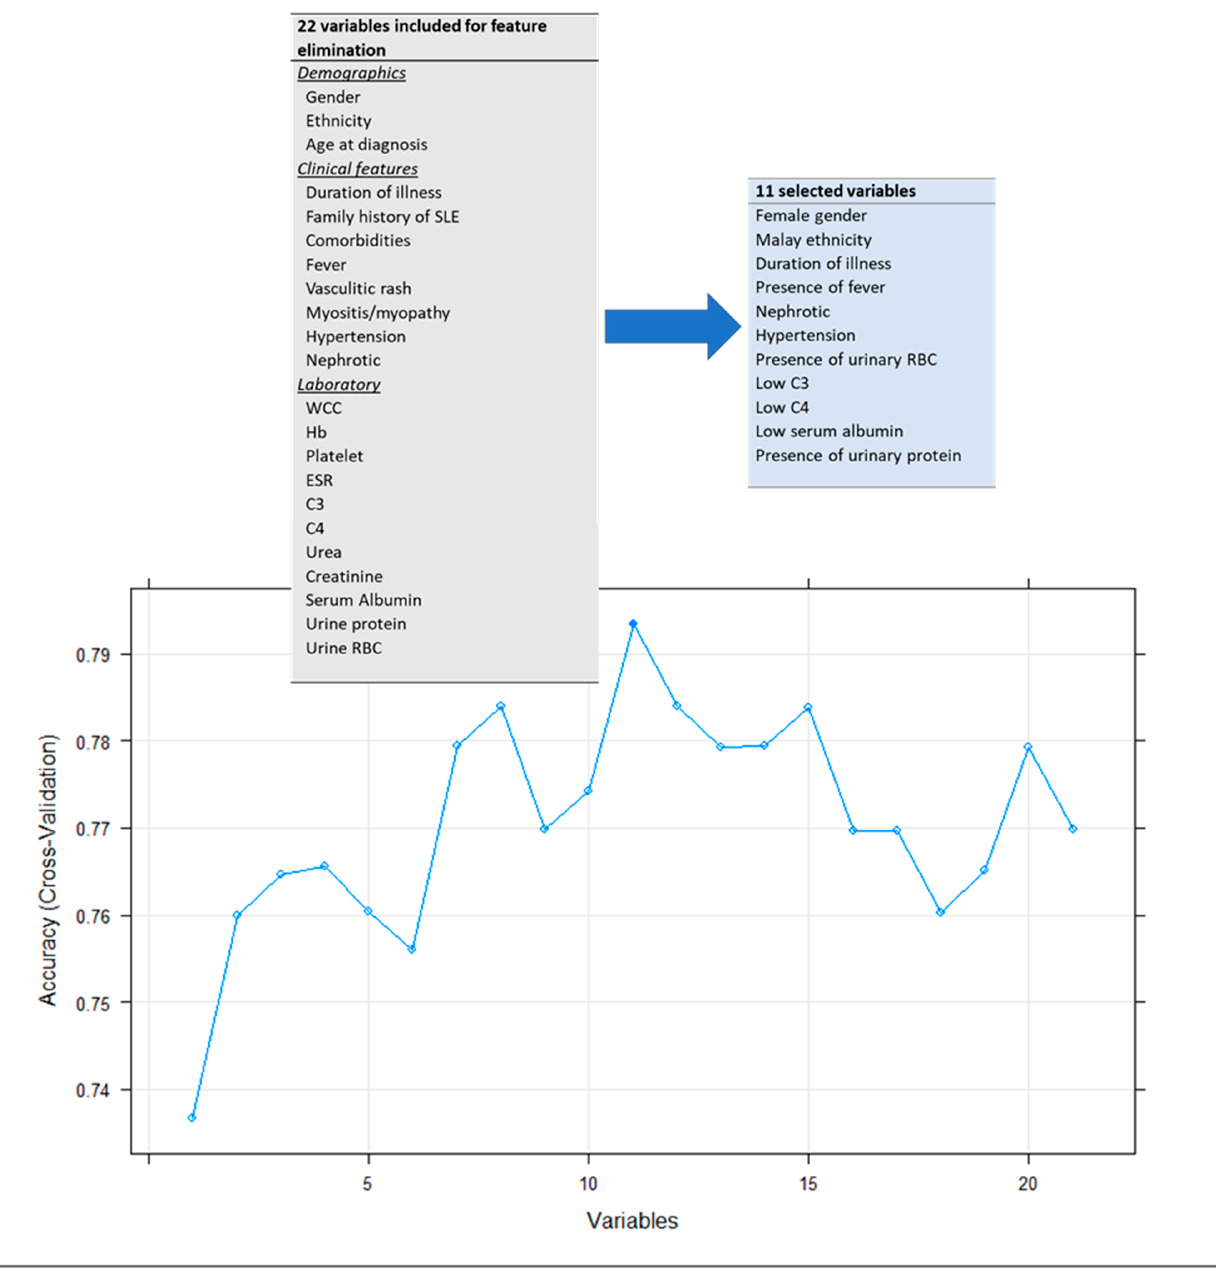
Figure 2. Recursive Feature Elimination with cross validation. A combination of 11 variables, namely (1) gender, (2) ethnicity, (3) fever, (4) nephrotic, (5) hypertension, (6) Urine RBC, (7) C3, (8) C4, (9) duration of illness, (10) serum albumin, and (11) urine protein had the highest accuracy of 79.4% in predicting proliferative lupus nephritis. After the 11 variables, the accuracy decreases with the increase in the number of variables.